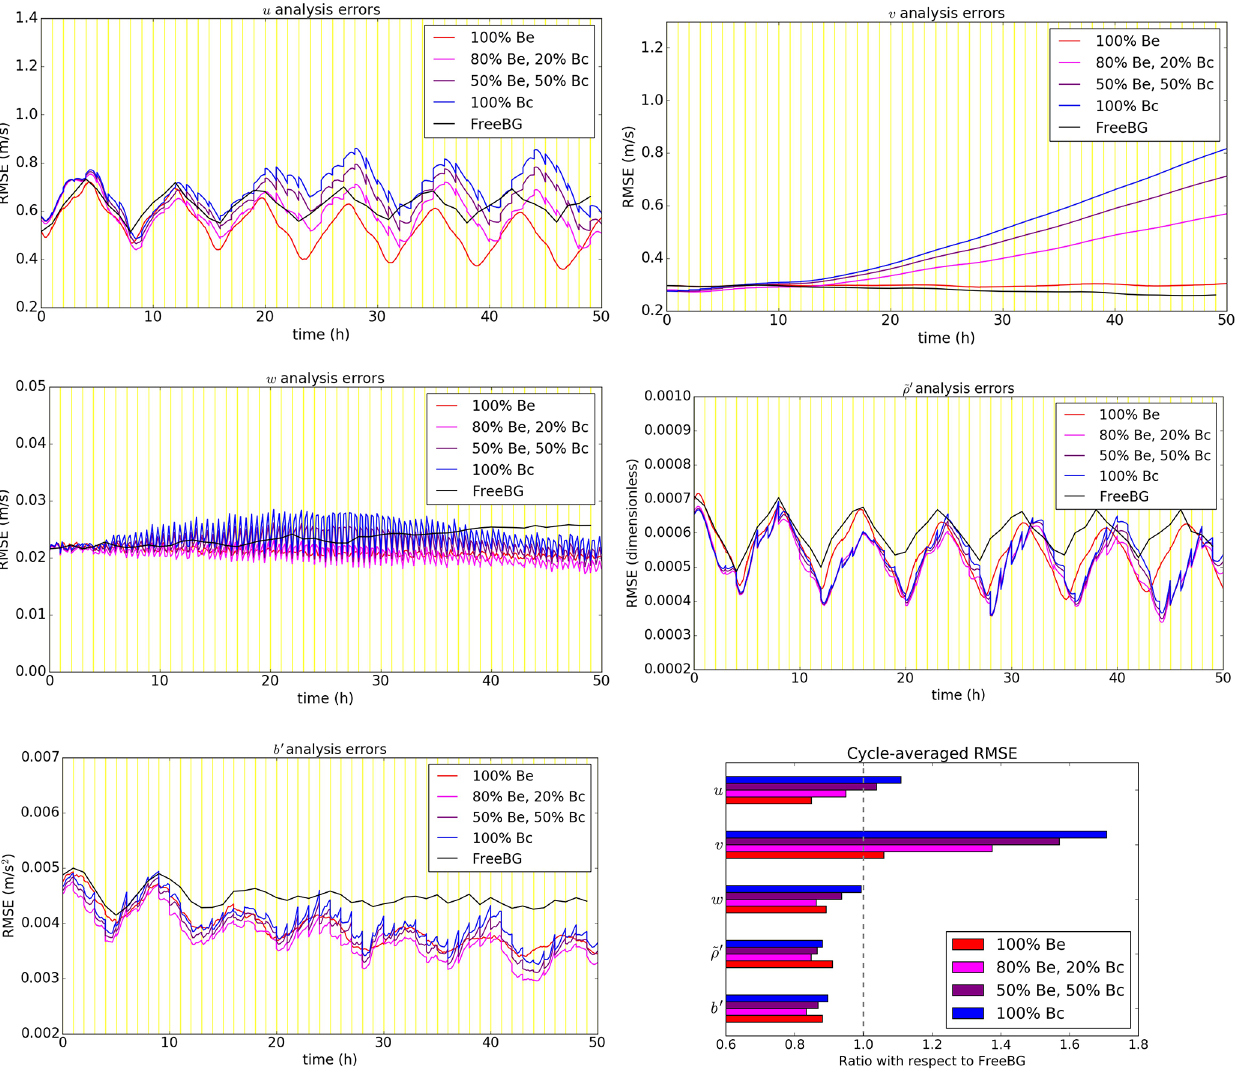
Figure 5. All panels except bottom right: time series of root mean square analysis errors for the EBV experiments (100% B c , configuration EBV(a); 50% B e , 50% B c , EBV(b); 80% B e , 20% B c , EBV(c); 100% B e , EBV(d)) and the free background run (FreeBG). The vertical yellow lines are the analysis times. Analysis errors are defined with respect to the “truth” run computed every 10min within the respective assimilation windows for EBV experiments and every hour for FreeBG. Bottom right: the ratio of the cycle-averaged RMSE of the EBV experiments with respect to FreeBG for the five ABC model